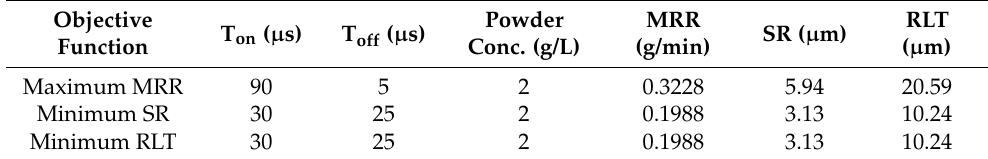
Table 6. Single-objective optimization results.